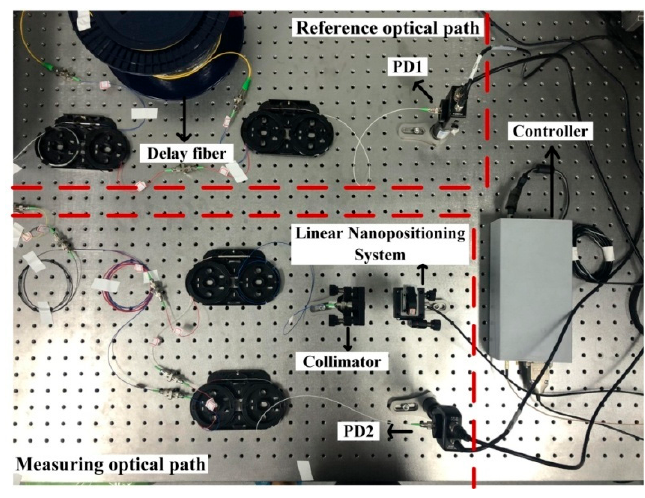
Figure 2. The experimental setup.